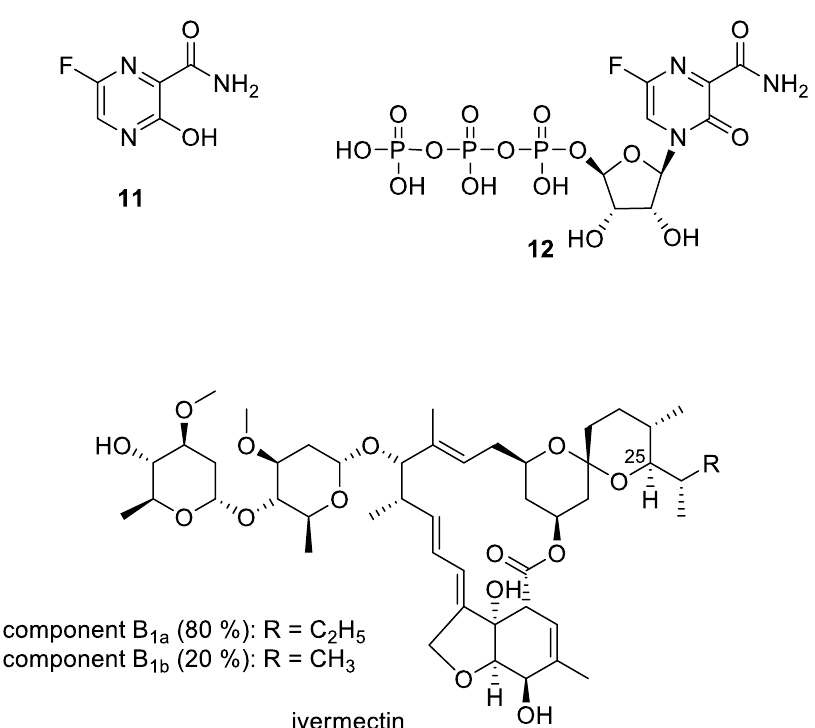
Figure 5. Chemical structure of favipiravir ( 11 ), its metabolite 12 , and ivermectin ( 13 – 14 ).